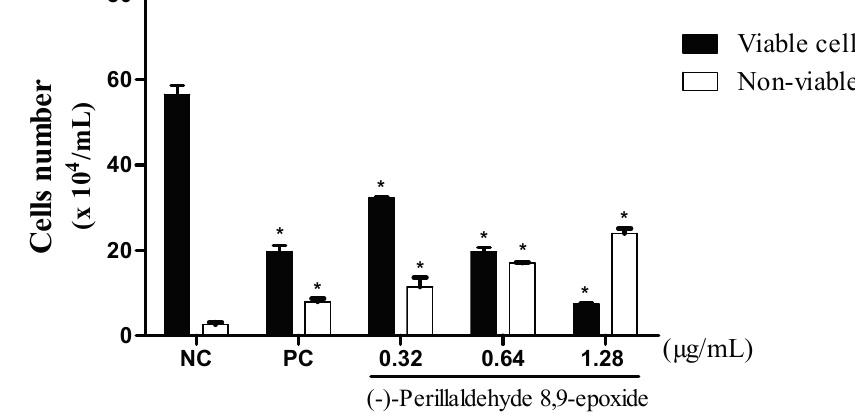
Figure 2. Effect of 16 on leukemic cell (HL-60) proliferation as measured by the trypan blue dye exclusion method after 24 h of incubation. The negative control was treated with the same vehicle (NC, 0.1% DMSO) used for diluting the test substance. Doxorubicin (PC, 0.3 µg/mL) was used as the positive control. Data are presented as mean values ± S.E.M. of two or three independent experiments performed in duplicate. * p < 0.05 compared to negative control by ANOVA followed by Student-Newman-Keuls